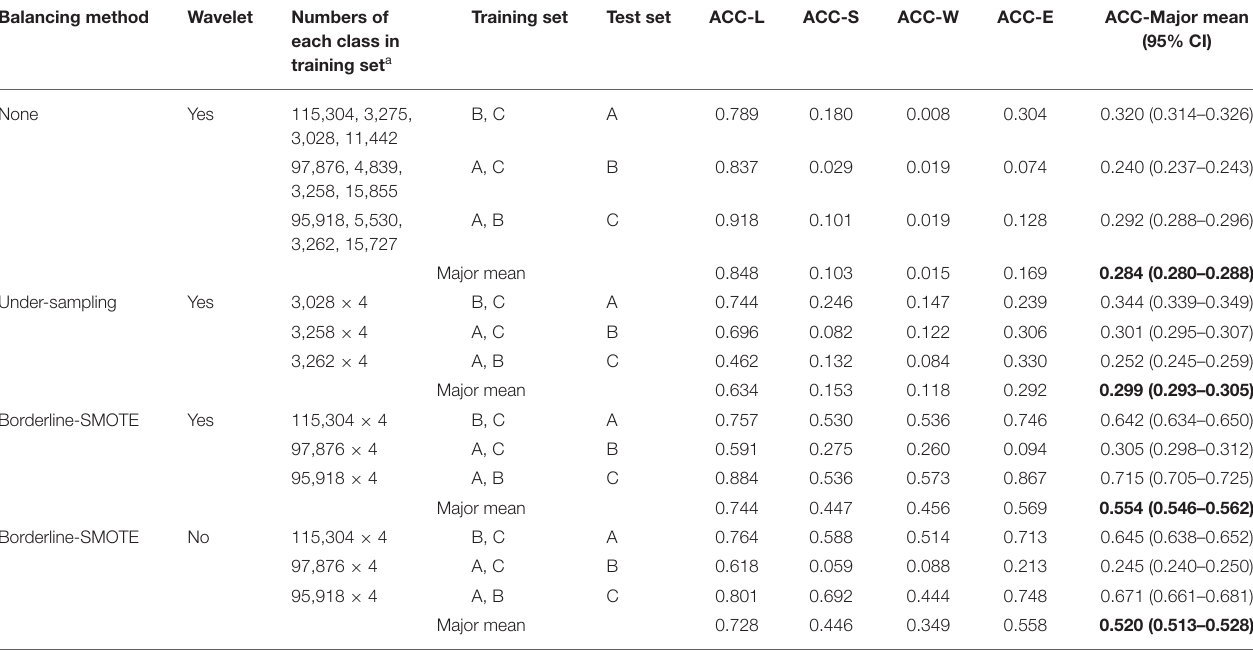
FIGURE 2 | Proportion of original four behaviors of each pig (A) and proportion of four behaviors of each pig after data augmentation (B) . TABLE 1 | Classification results by using wavelet filtering, under-sampling, and over-sampling with BL-SMOTE on the training